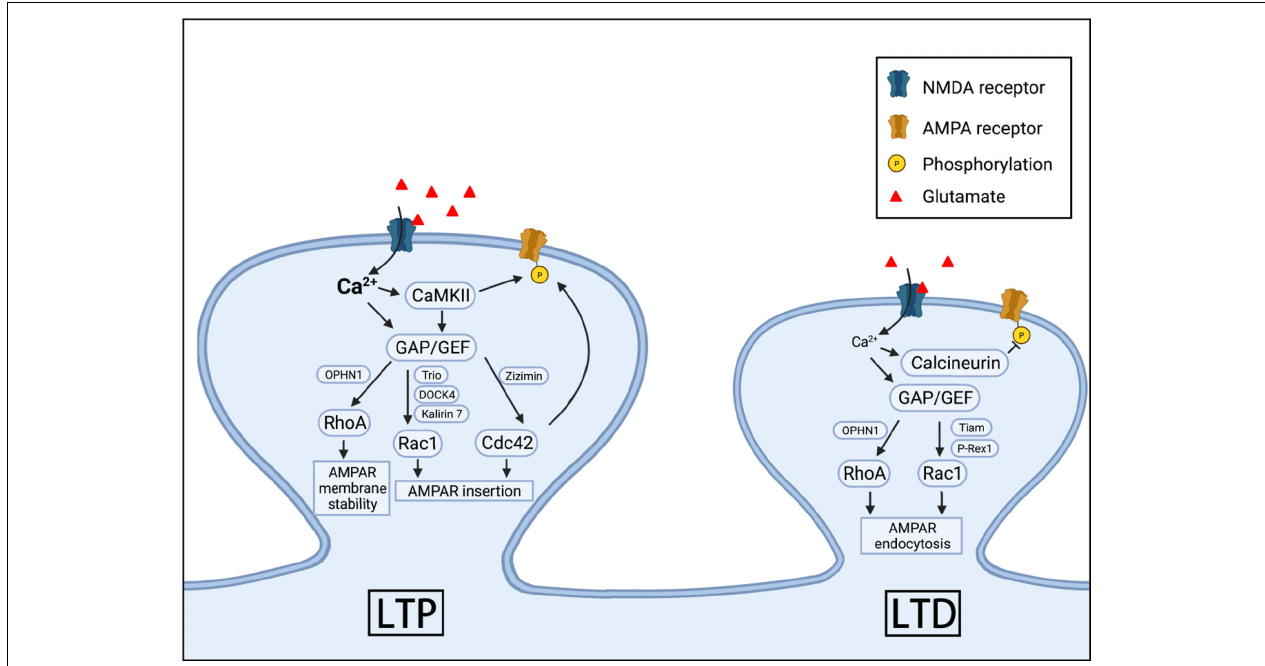
FIGURE 2 | Rho GTPases in AMPAR expression, LTP and LTD. RhoA, Cdc42, and Rac1 can participate in the regulation of the synaptic insertion, internalization and membrane stability of AMPARs during LTP and LTD. These GPTases are activated by NMDARs or other surface proteins through various GAPs and